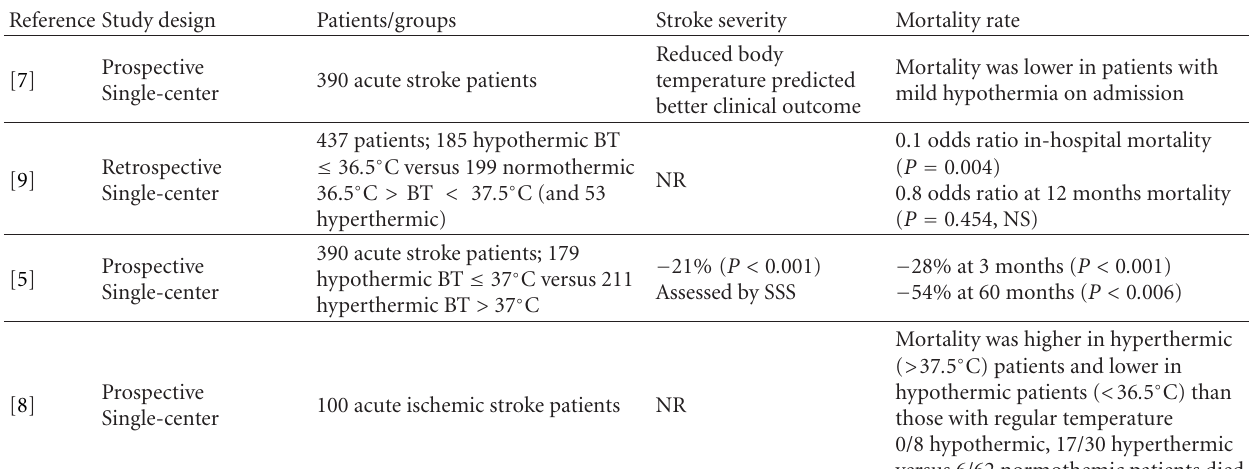
Table 1: Observational studies (no intervention) of admission body temperature and mortality rate after acute